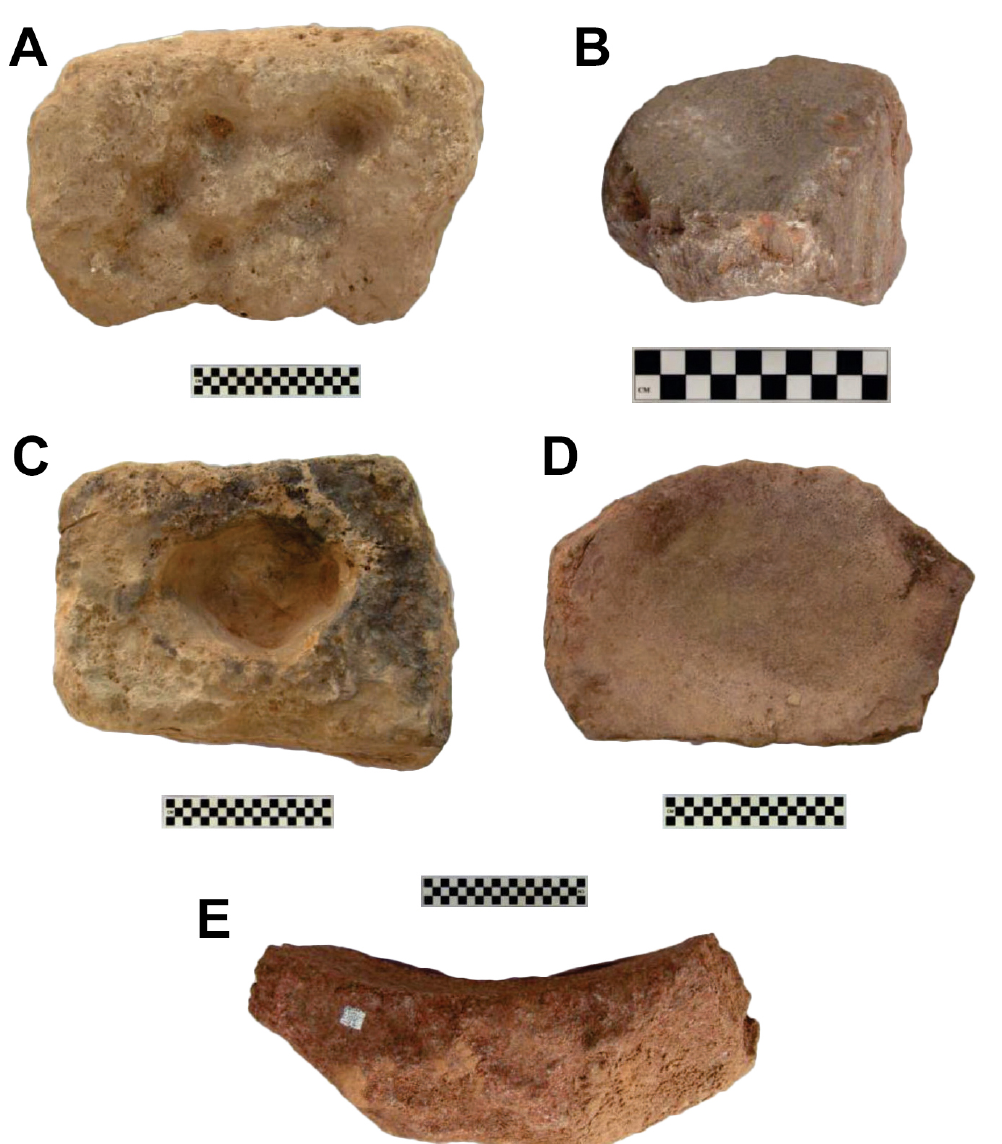
Figure 12. Selected netherstones from Khirbat en-Nahas, 2006 excavations. A, anvil, Area T, Locus 1519; B, small dimpled anvil, Area R, Locus 1804; C, mortar, Area T, Locus 1511; D, grinding slab, Area T, Locus 1523; E, saddle quern, Area T, Locus 1507. Individual squares in the scale bars are 1 cm